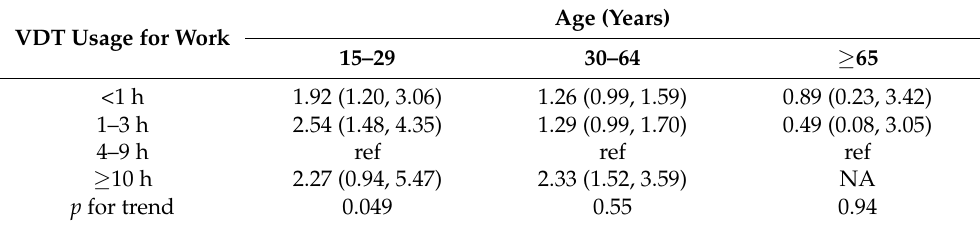
Table 5. Association between the VDT usage for work and severe psychological distress stratified by age